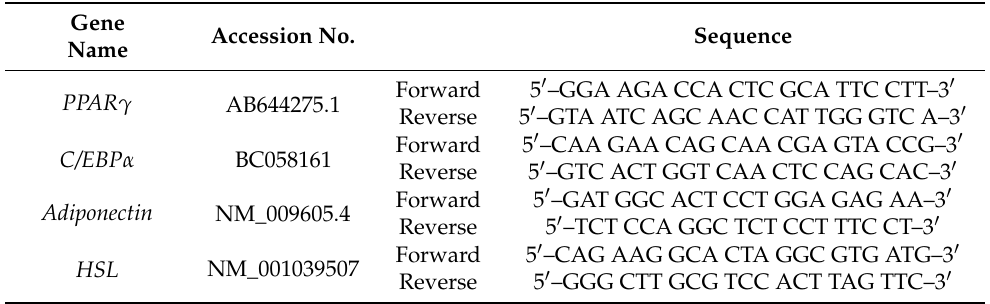
Table 1. Primer sequences for RT-PCR.